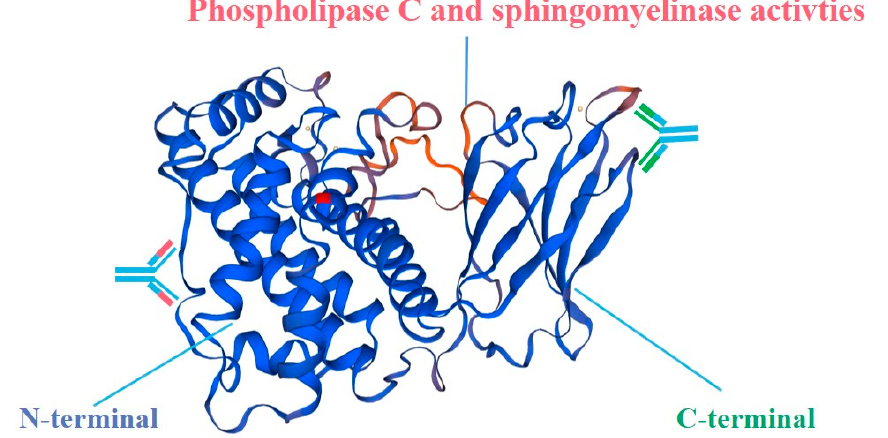
Figure 2. The three-dimensional (3D) structure of C. perfringens alpha toxin (CPA). Based on the 3D structure to design the N-terminal (1–249 aa) and C-terminal (247–370 aa) domain protein